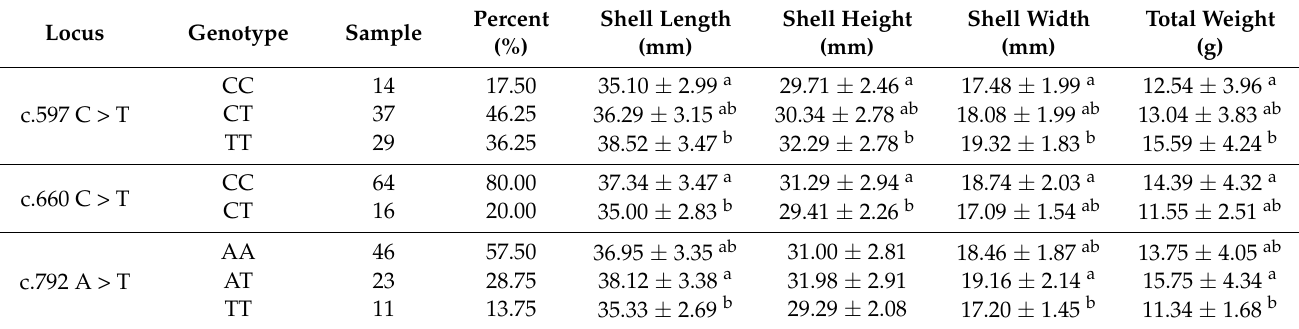
Table 2. Correlation analysis between the SNPs and growth traits of M. meretrix.